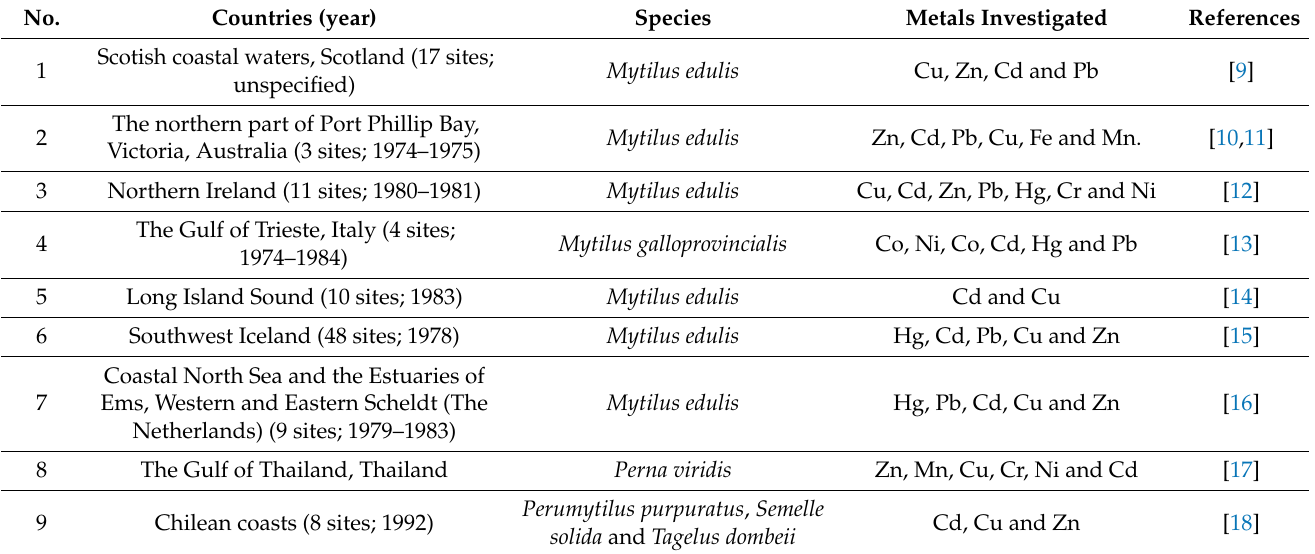
Table 1. A review on the use of bivalves’ soft tissues for metal pollution studies from some of the available literature. No. Countries (year) Species Metals